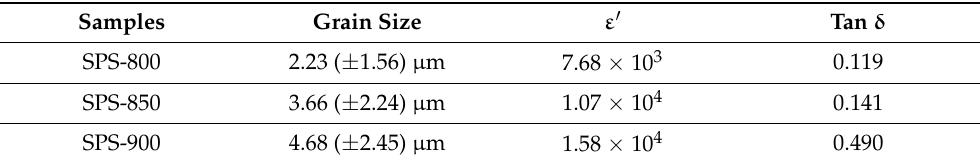
Table 3. Grain size, the corresponding dielectric constant, and loss values for samples sintered from 800 to 900 ◦ C